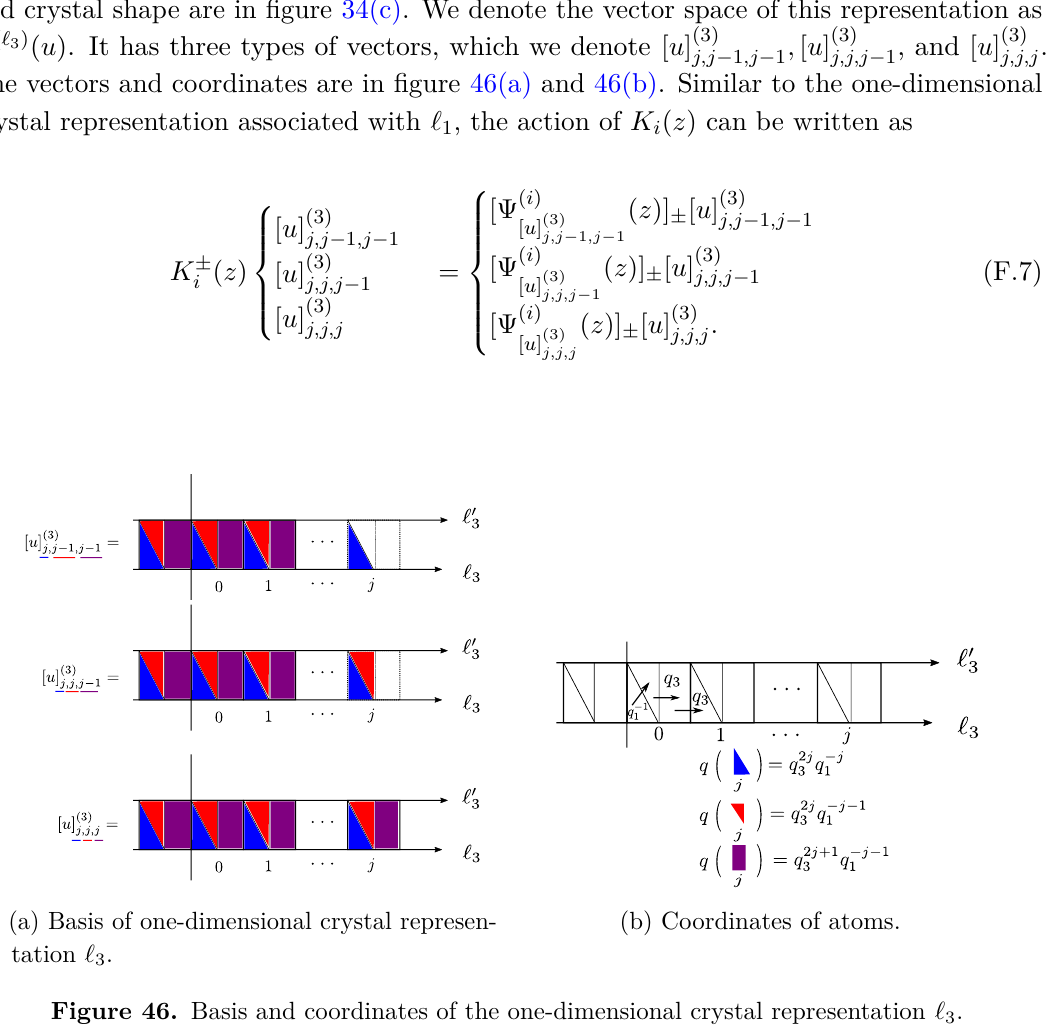
(a) Basis of one-dimensional crystal represen- tation ‘ . 3 Figure 46. Basis and coordinates of the one-dimensional crystal representation ‘ 3